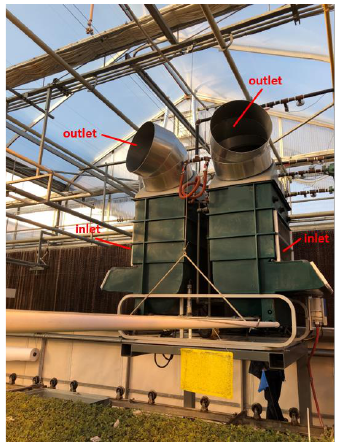
Figure A3. LDD in greenhouse bay. Energies 2023 , 16 , x FOR PEER REVIEW Figure A3. LDD in greenhouse bay. Figure A3. LDD in greenhouse bay.